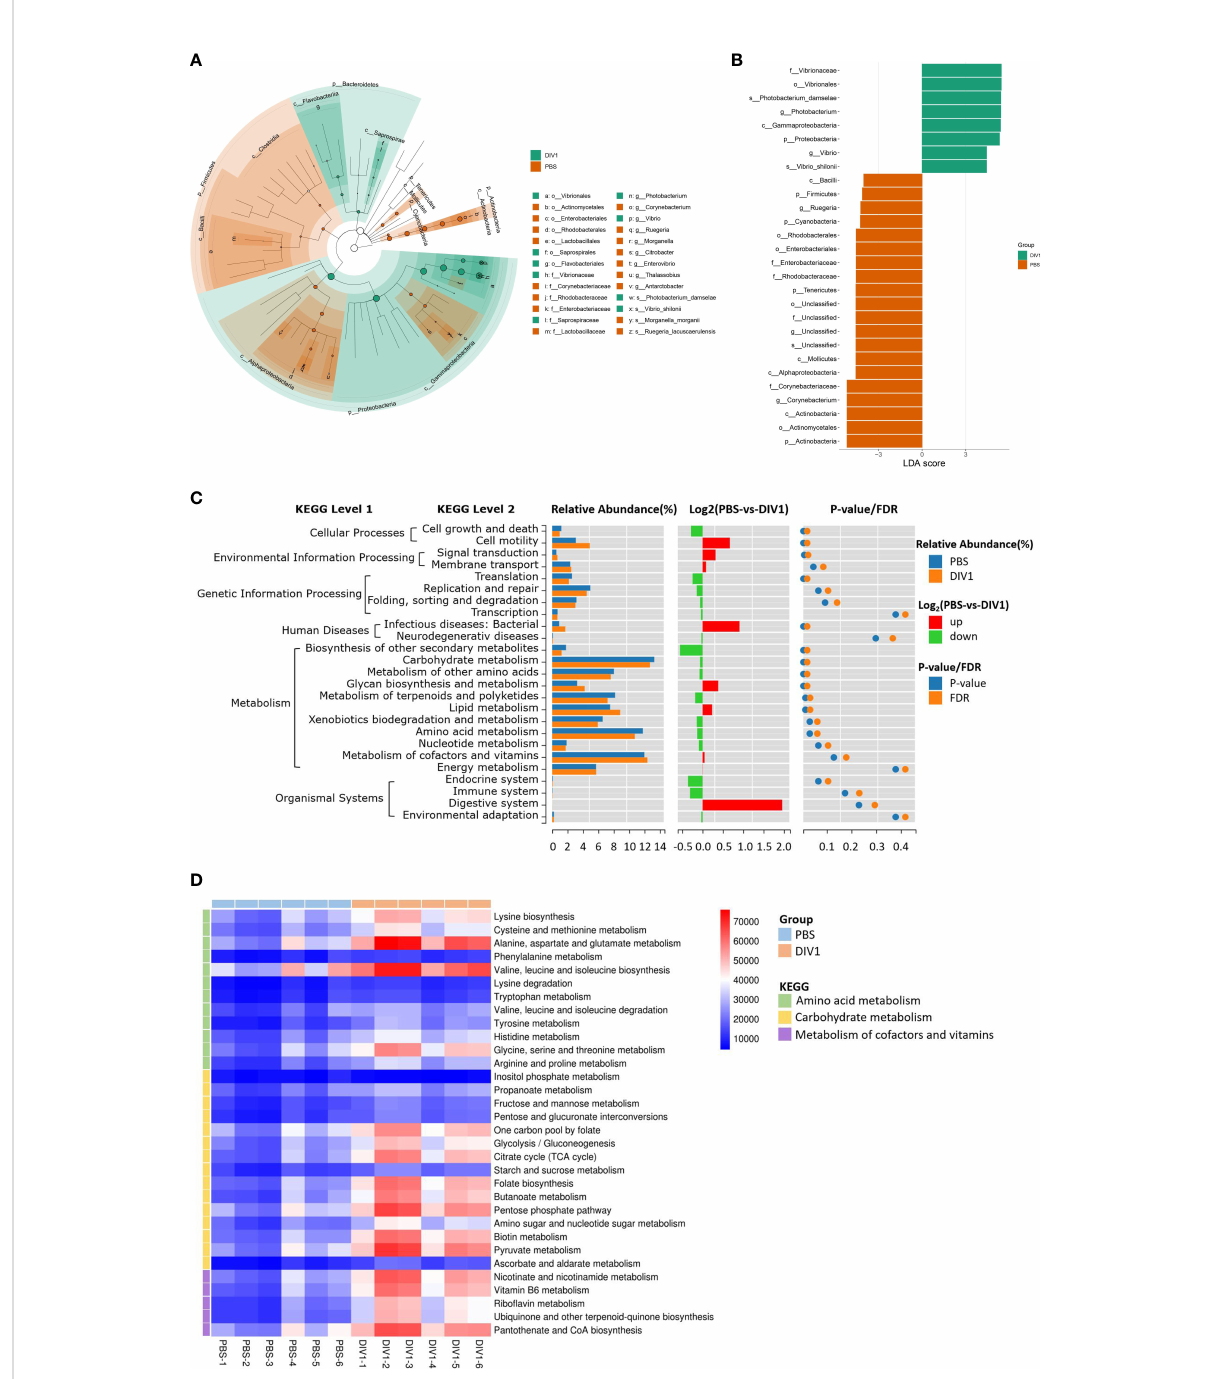
FIGURE 5 Intergroup variation, functional analysis of intestinal microbiota of M. japonicus after DIV1 infection. (A) LEfSe cladogram. (B) LDA score of LEfSe-PICRUSt. (C) Microbial metabolism prediction based on KEGG pathway analysis (KEGG level 2). (D) Abundance clustering heat map of predicted functions of intestinal microbiota in each sample (KEGG level